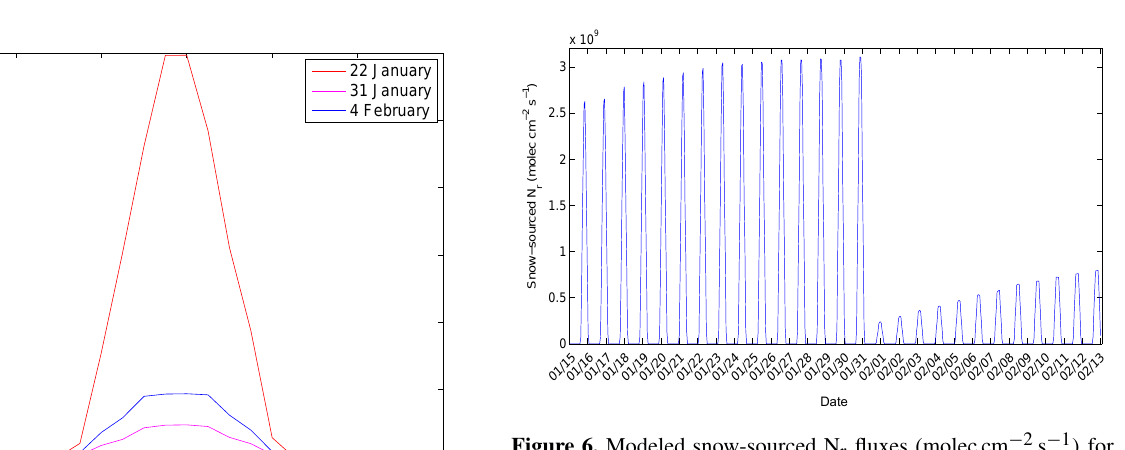
Figure 6. Modeled snow-sourced N r fluxes (moleccm − 2 s − 1 ) for each hour during the campaign from 15 January to 11 , r